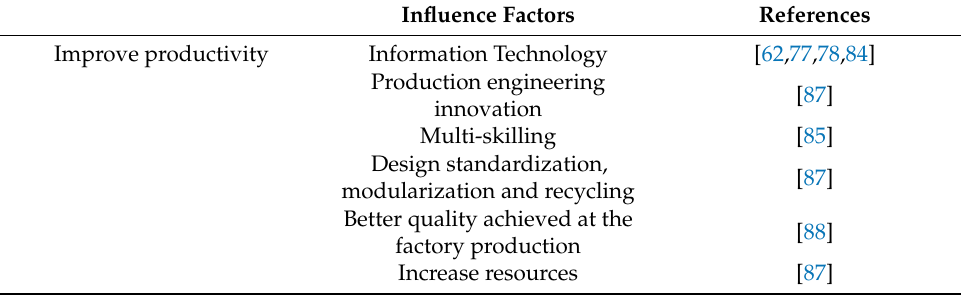
Table 2. Existing study on the key factors influencing the productivity of prefabrication. Influence